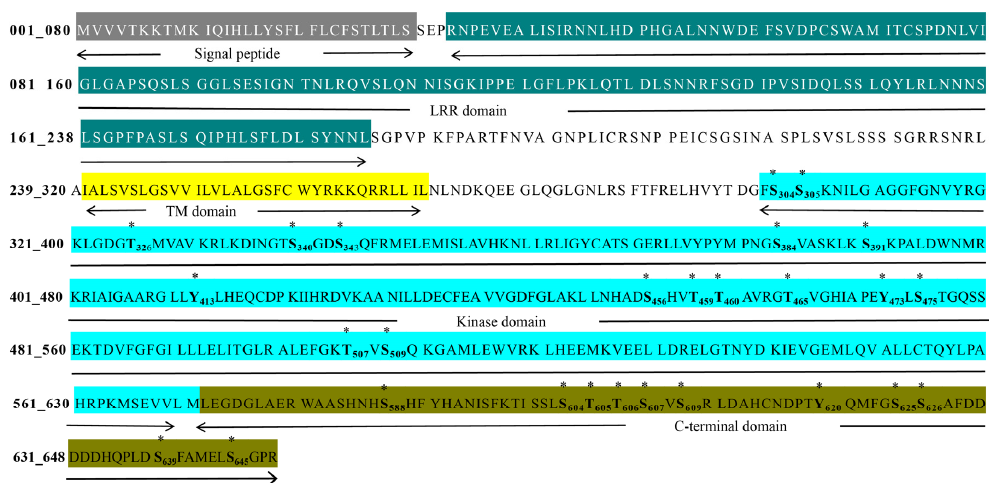
Figure 1. Predicted autophosphorylation sites of Arabidopsis thaliana senescence-associated receptor like kinase AtSARK by liquid chromatography-tandem mass spectrometry (LC-MS/MS). The signal peptide, leucine rich repeat (LRR) domain, transmembrane (TM) domain, kinase domain, and C-terminal domain of full-length AtSARK protein are highlighted in different colors and marked with the solid line below the sequence. All 27 potential autophosphorylation residues of AtSARK predicted by LC-MS/MS are shown in bold letters and indicated with stars